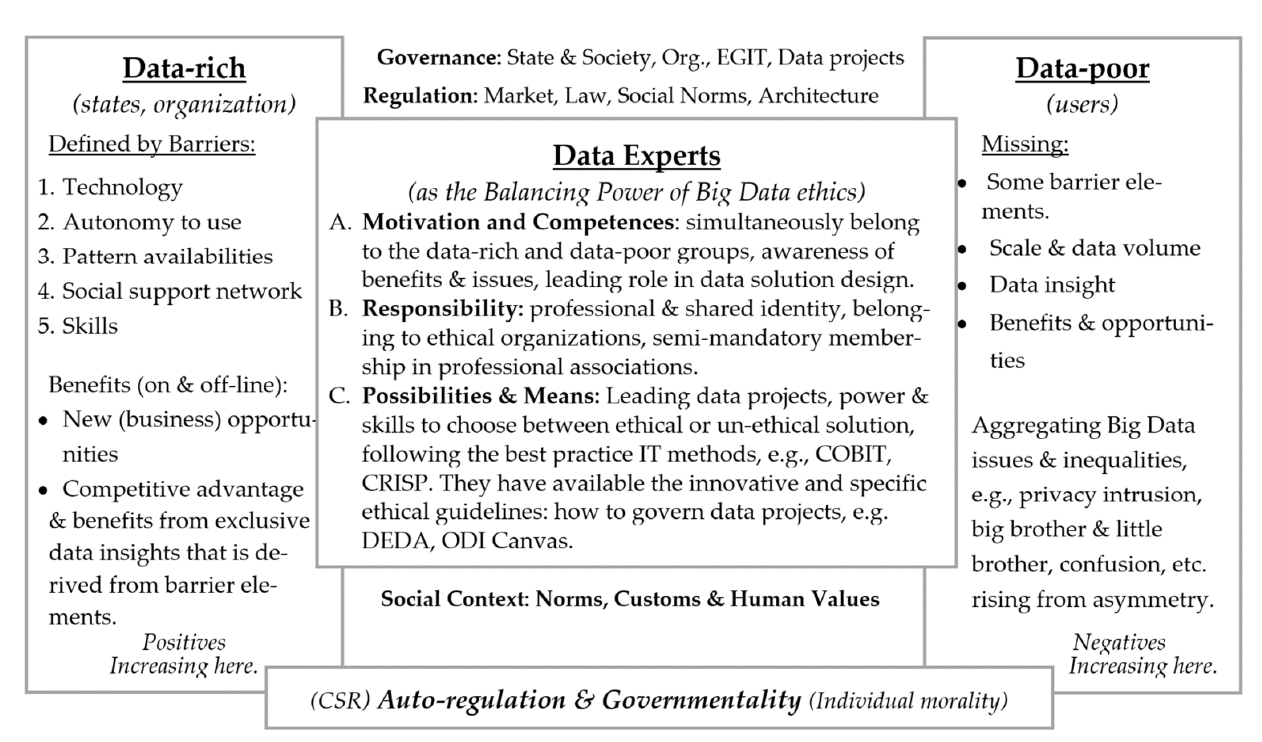
Figure 1. Model mapping the role of data experts in Big Data ethics and describing them as a balancing power.